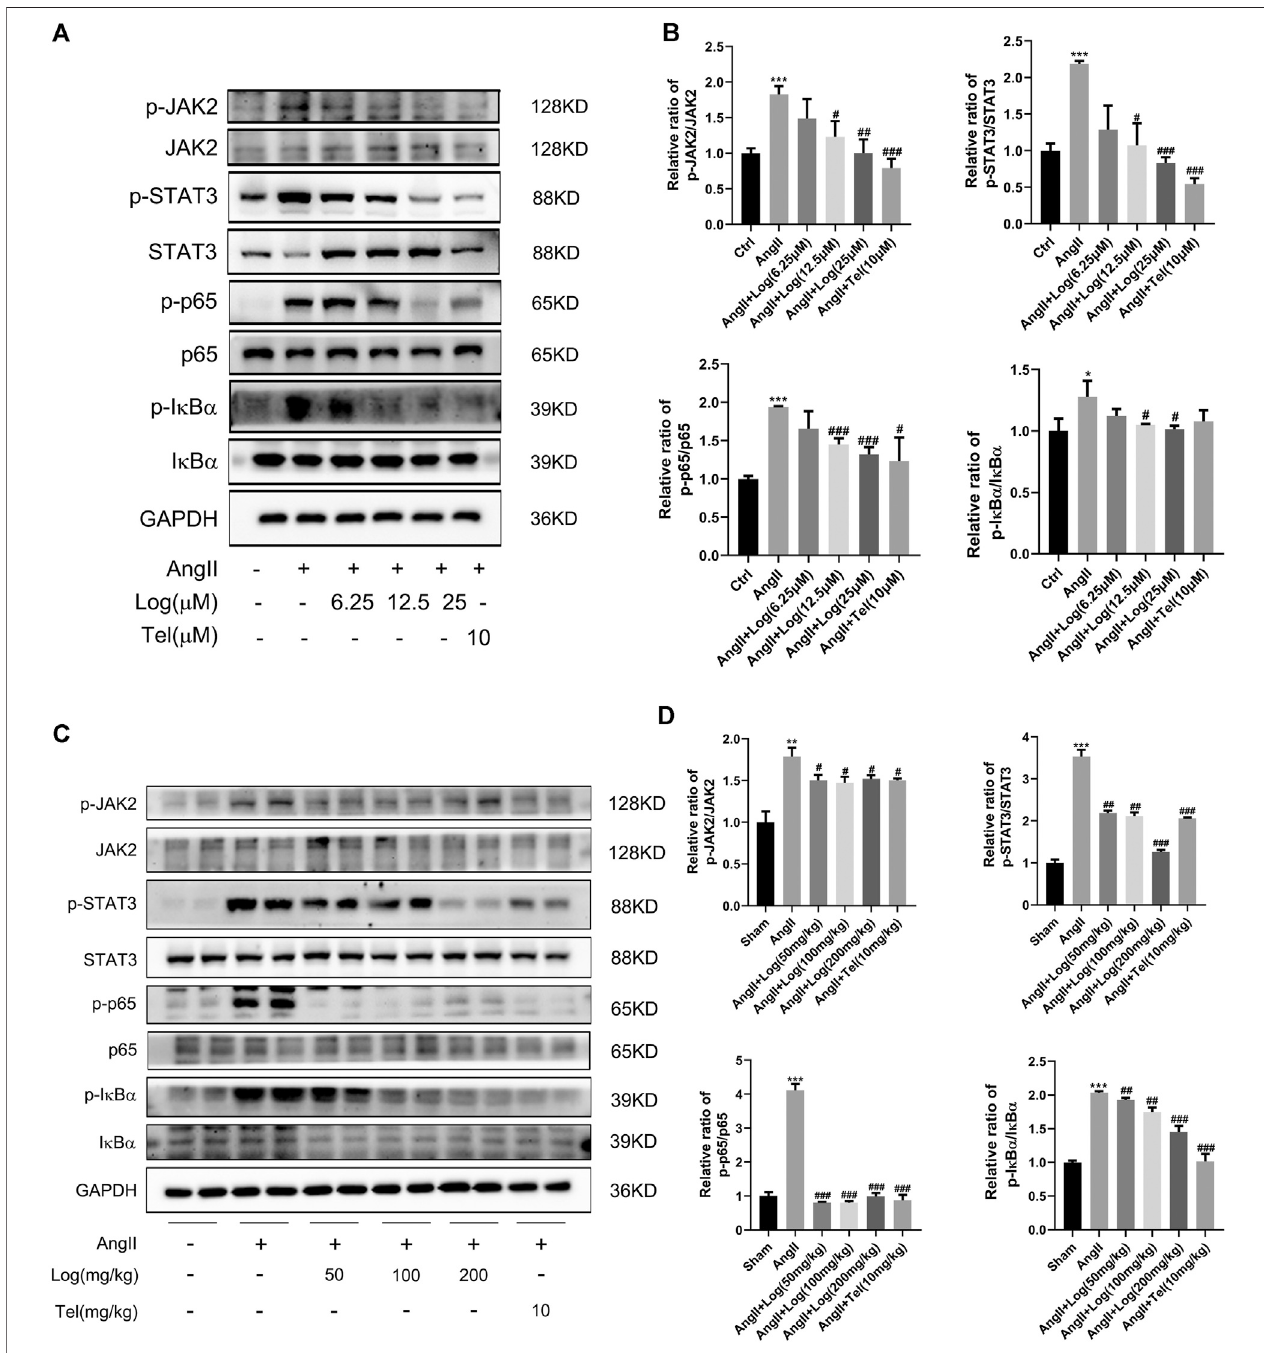
FIGURE4| LoganininhibitsAngII – inducedactivationoftheJAK2/STAT3andNF- κ Bsignalingpathways. (A,C) Theexpressionlevelsofsignalingpathwayproteins (total and phosphorylation of JAK2, STAT3, p65, and I κ B α ) are determined by western blot in vitro and in vivo . (B,D) Quanti fi cation of the relative changes in phosphorylation of JAK2, STAT3, p65, and I κ B α . GAPDH is used for normalization. Data are expressed as mean ± SD ( n (cid:2) 3). * p < 0.05, ** p < 0.01, *** p < 0.001 vs the control/sham group; # p < 0.05, ## p < 0.01, ### p < 0.001 vs the Ang II – treated group (analyzed using one-way ANOVA). Telmisartan (Tel) is a positive control